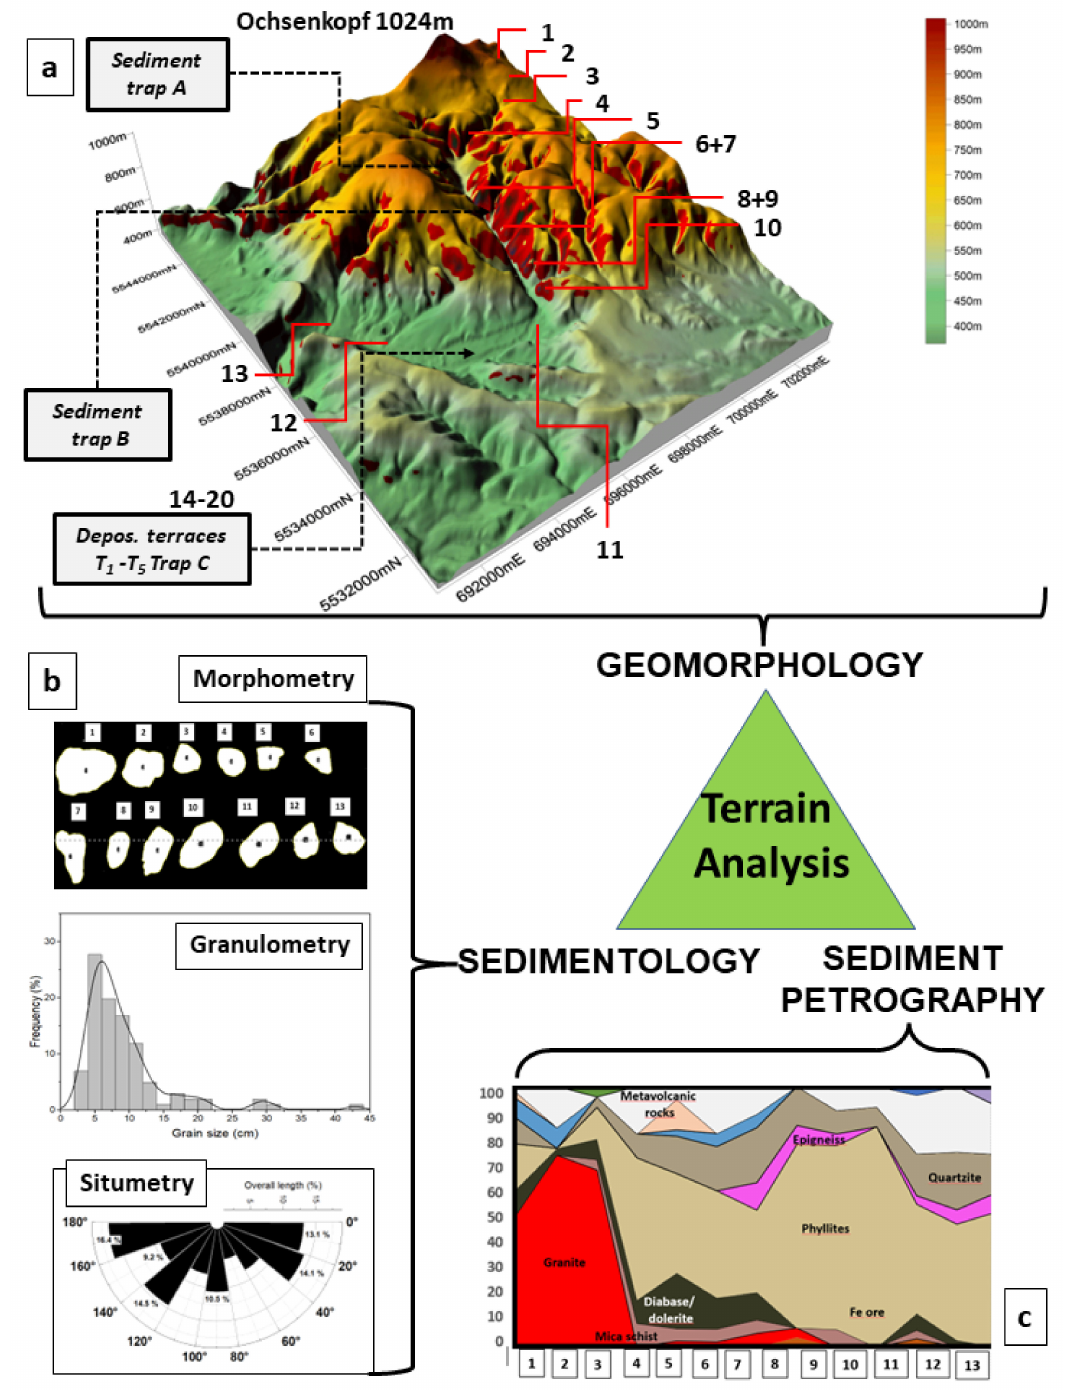
Figure 20. Synopsis of and advanced-level terrain analysis. ( a ) Numerical geomorphology of land- scapes and landform series (supplemented with geochronology called relief generations) and geology. ( b ) Numerical sedimentology (this study of the GMS tool). ( c ) Numerical sediment petrography covering the full grain size spectrum from gravel, from sand to